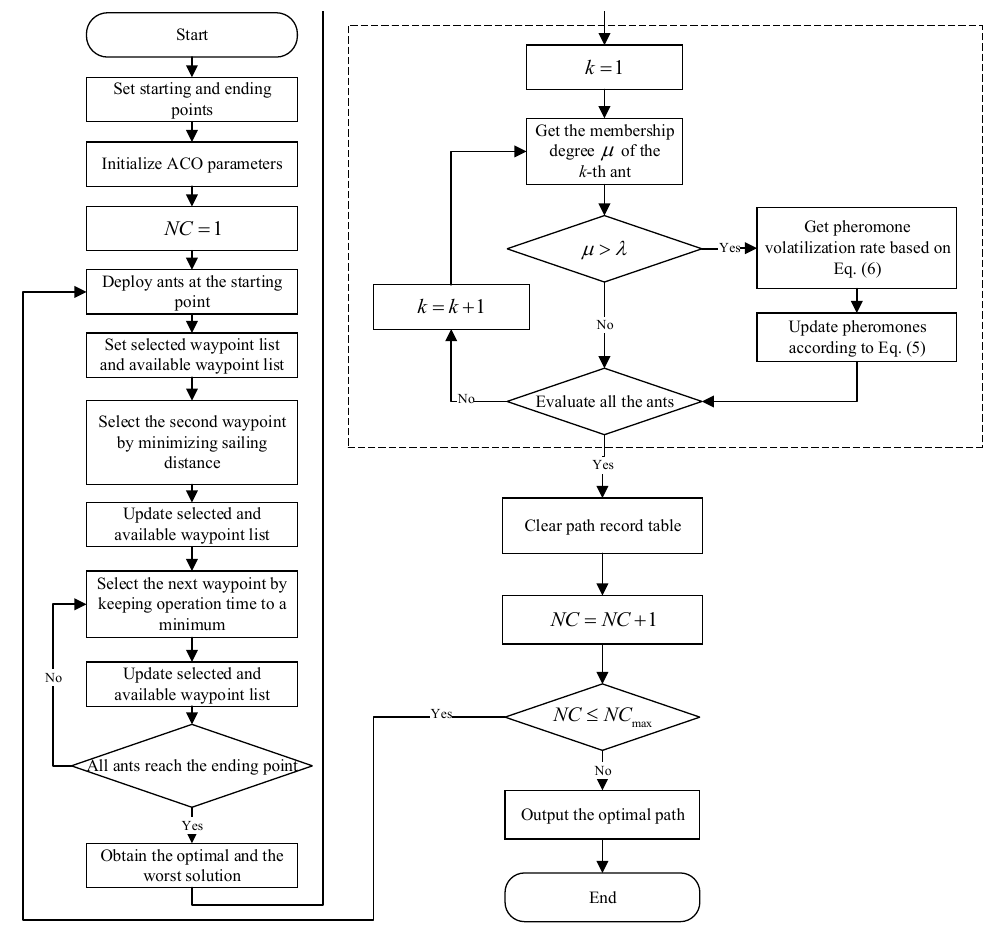
Figure 3. Flow chart of the improved ACO